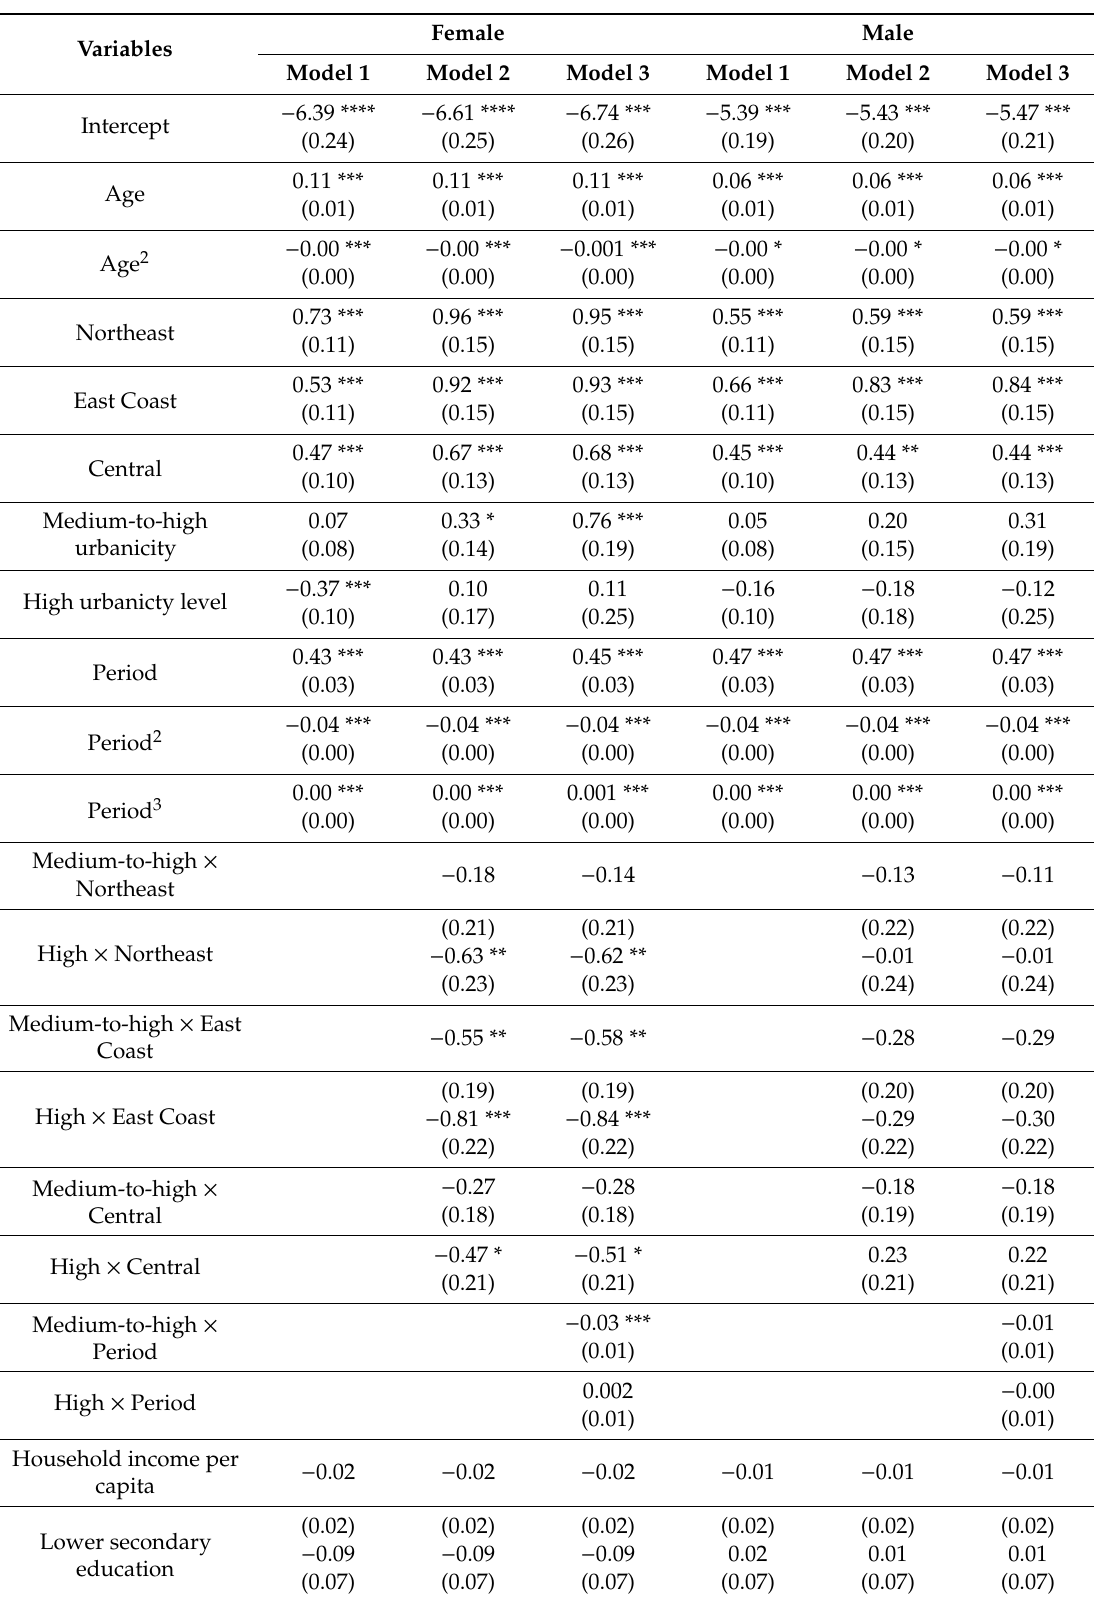
Table 2. Estimates of multilevel logistic analyses, complete case analyses, China Health and Nutrition Survey (1991–2015) a .